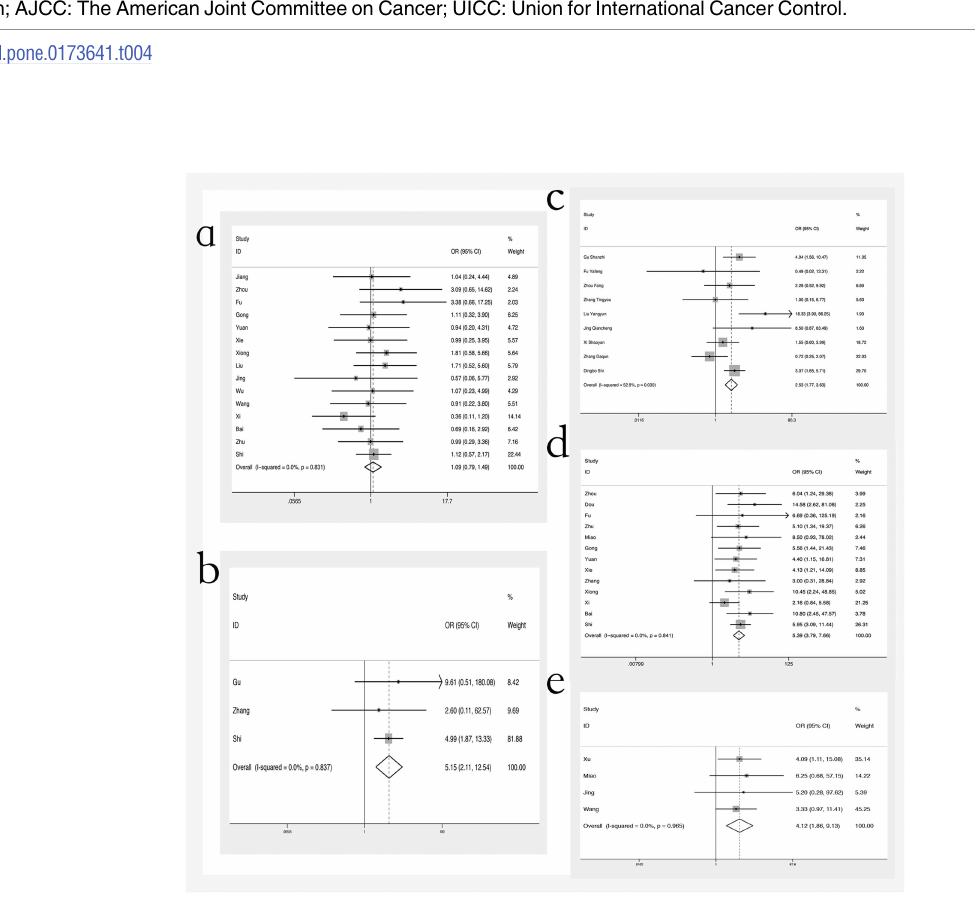
Fig 4. Forest plots: odds ratio (OR) for other clinicopathological parameters. (a) sex (male vs female); (b) metastasis (M1 vs M0); (c) tumor size (T1/T2 vs T3/T4); (d) TNM stage (I/II vs III/IV); (e) differentiation (low vs